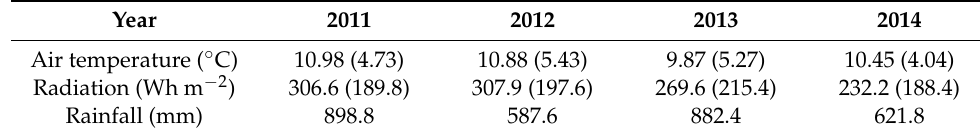
Table 2. Median and median absolute deviation with a consistency constant of 1.4826 for the normal distribution (in brackets) of air temperature and daily solar radiation (the sum of hourly records) at 200 cm above ground and total rainfall from May to October 2011–2014.